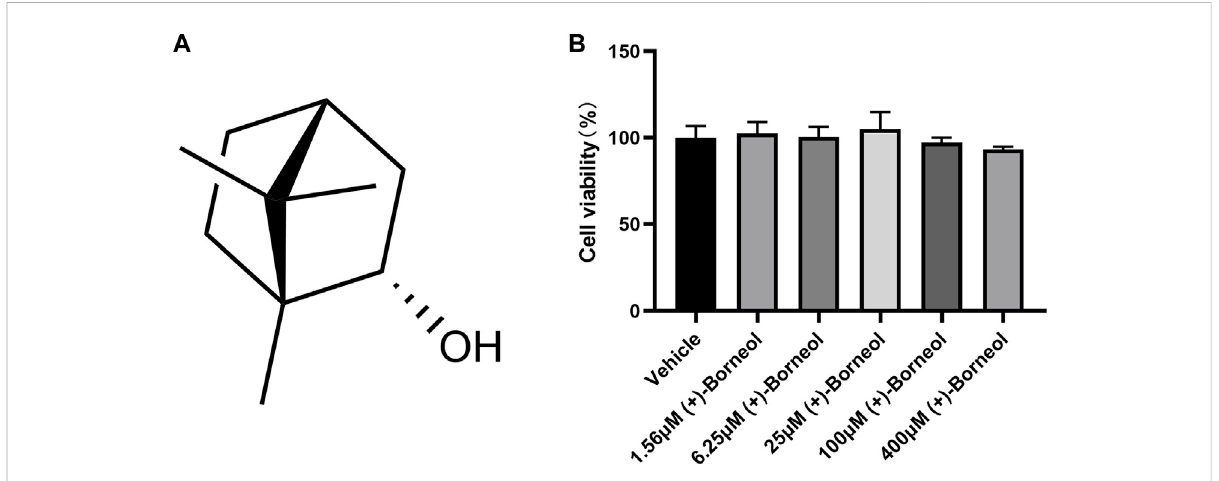
FIGURE 1 (+)-Borneol hasnoeffectonneutrophilviability. (A) Chemicalstructuralformulaof(+)-borneol. (B) 5×104neutrophilsfromhealthyvolunteers weretreatedwithdifferentconcentrationsof(+)-borneol(1.56,6.25,25,100,and400 μ M)for4 h,andthecellviabilitywasmeasuredusingaCCK-8 assay ( n =